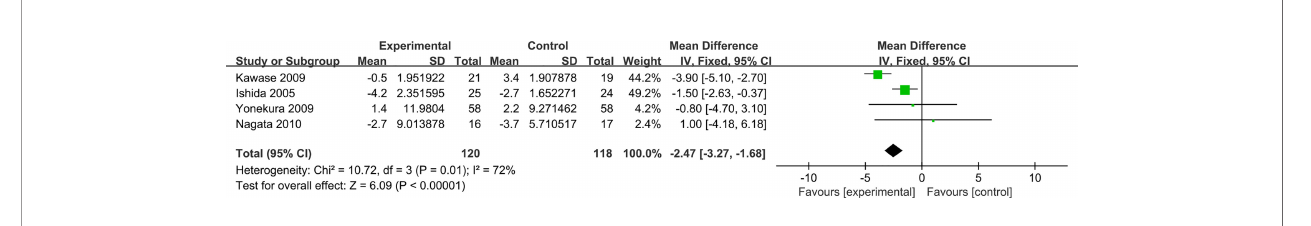
FIGURE 8 | Forest plot for